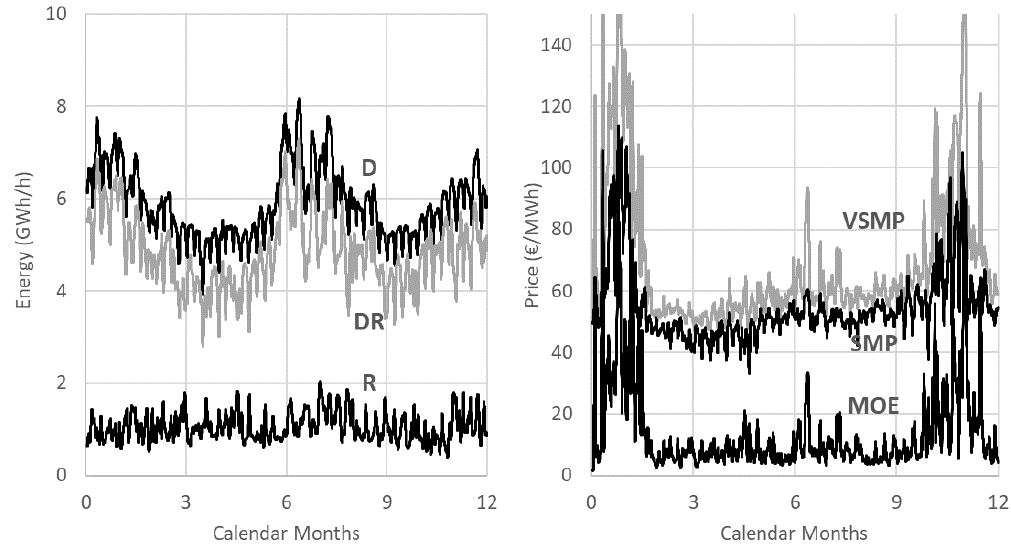
Figure 5. Seasonal variation using 24 hour moving averages: D = demand, DR = demand renewables, R = renewables, VSMP = virtual system marginal price, SMP = system marginal price, MOE = merit order effect.